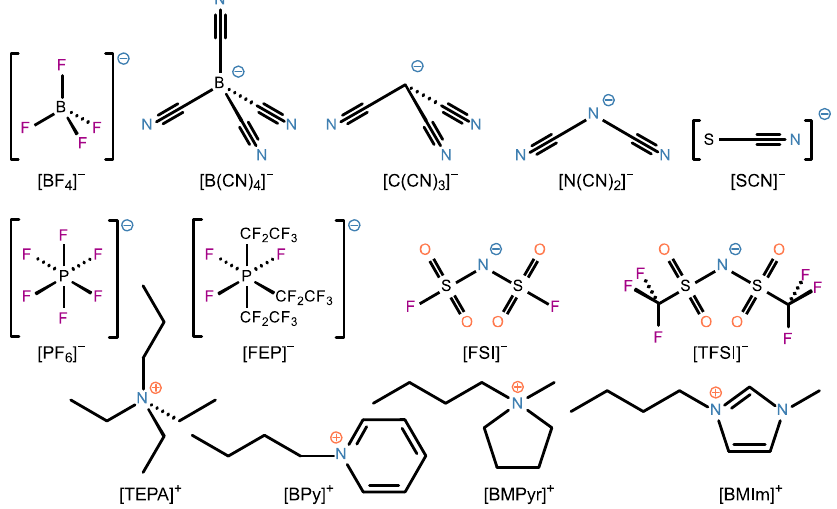
Figure 1. The individual anions and cations that are combined to make up the 48 ionic pairs. Starting from the top left: tetrafluoroborate, tetracyanoborate, tricyanomethanide, dicyanimide, isocyanate, hexafluorophosphate, tris(pentafluoroethyl)trifluorophosphate, bis(fluorosulfonyl)imide, bis(trifluoromethylsulfonyl)imide, triethylpropylammonium, 1-butylpyridinium, 1-butyl-1-methylpyrrolidinium, 1-butyl-3-methylimidazolium. Chloride, bromide, and iodide ions were also employed but are not shown in the figure.